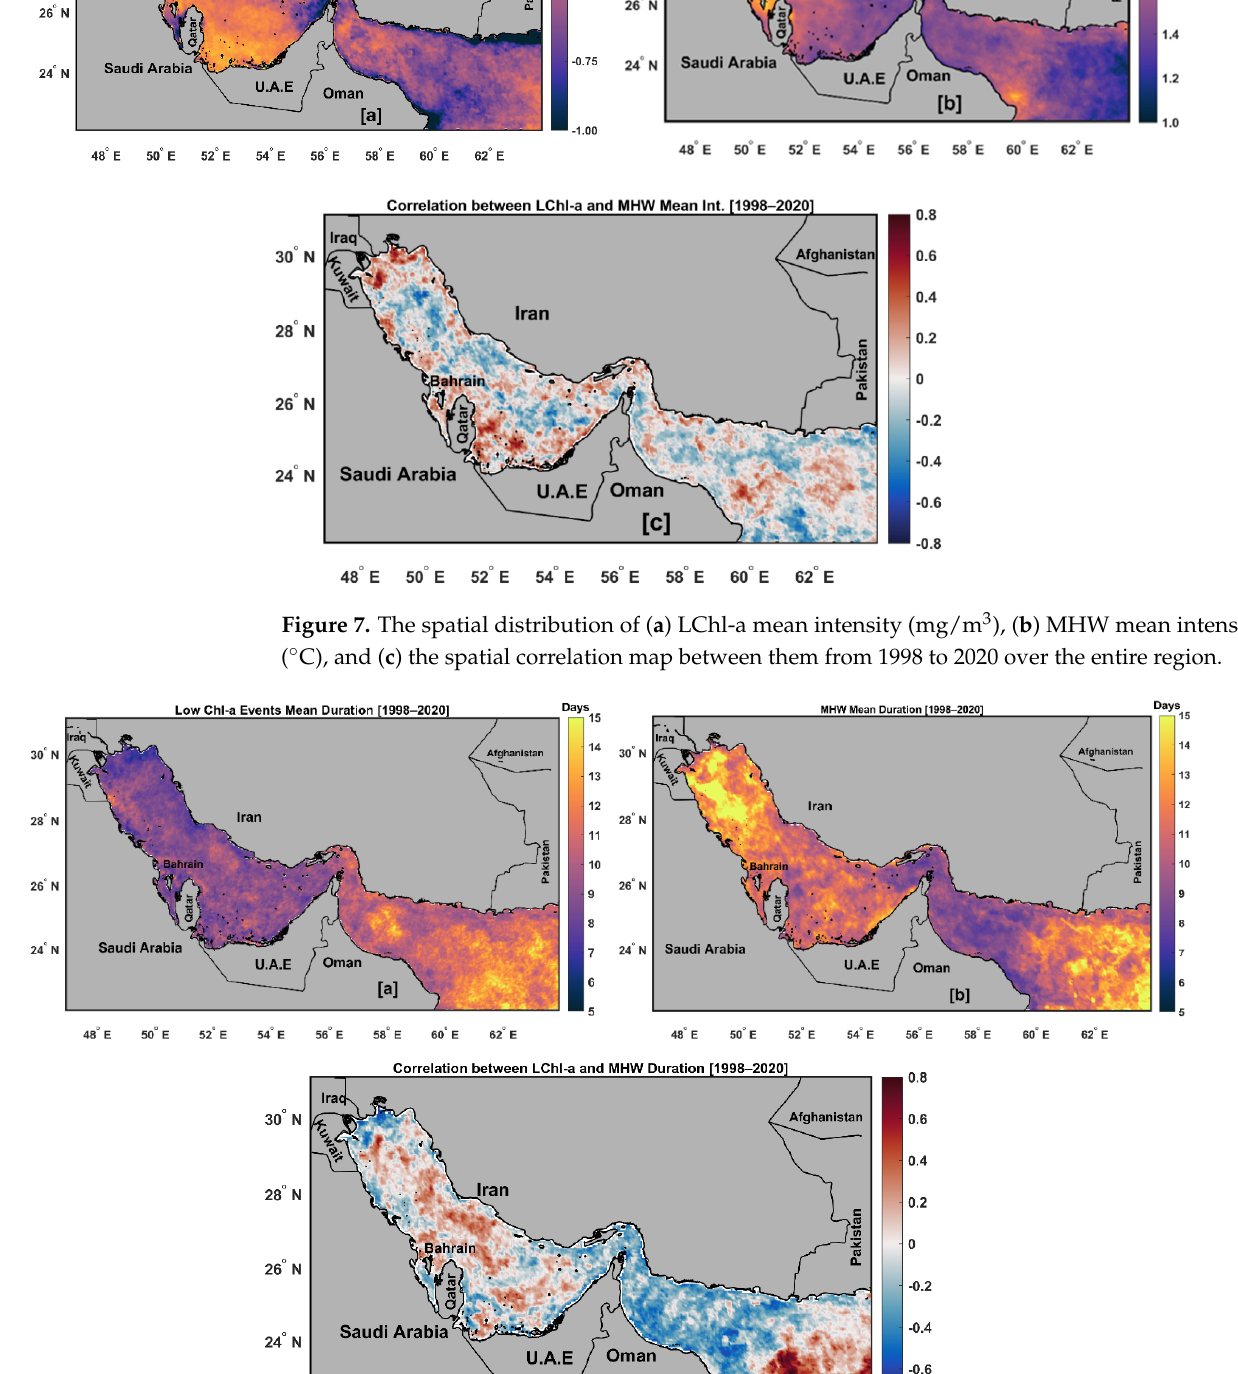
Figure 8. The spatial distribution of ( a ) LChl-a mean duration (days), ( b ) MHW mean duration (days), and ( c ) the spatial correlation map between them from 1998 to 2020 over the entire region.